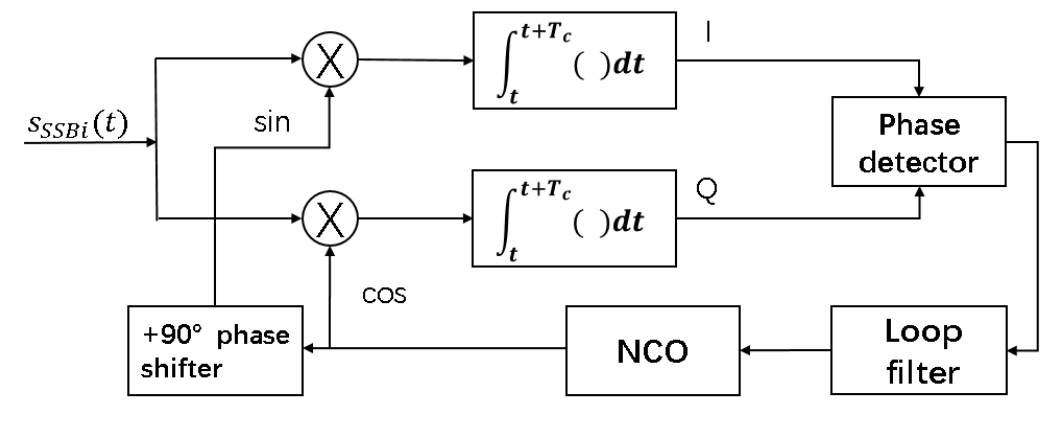
Figure 7. A typical carrier